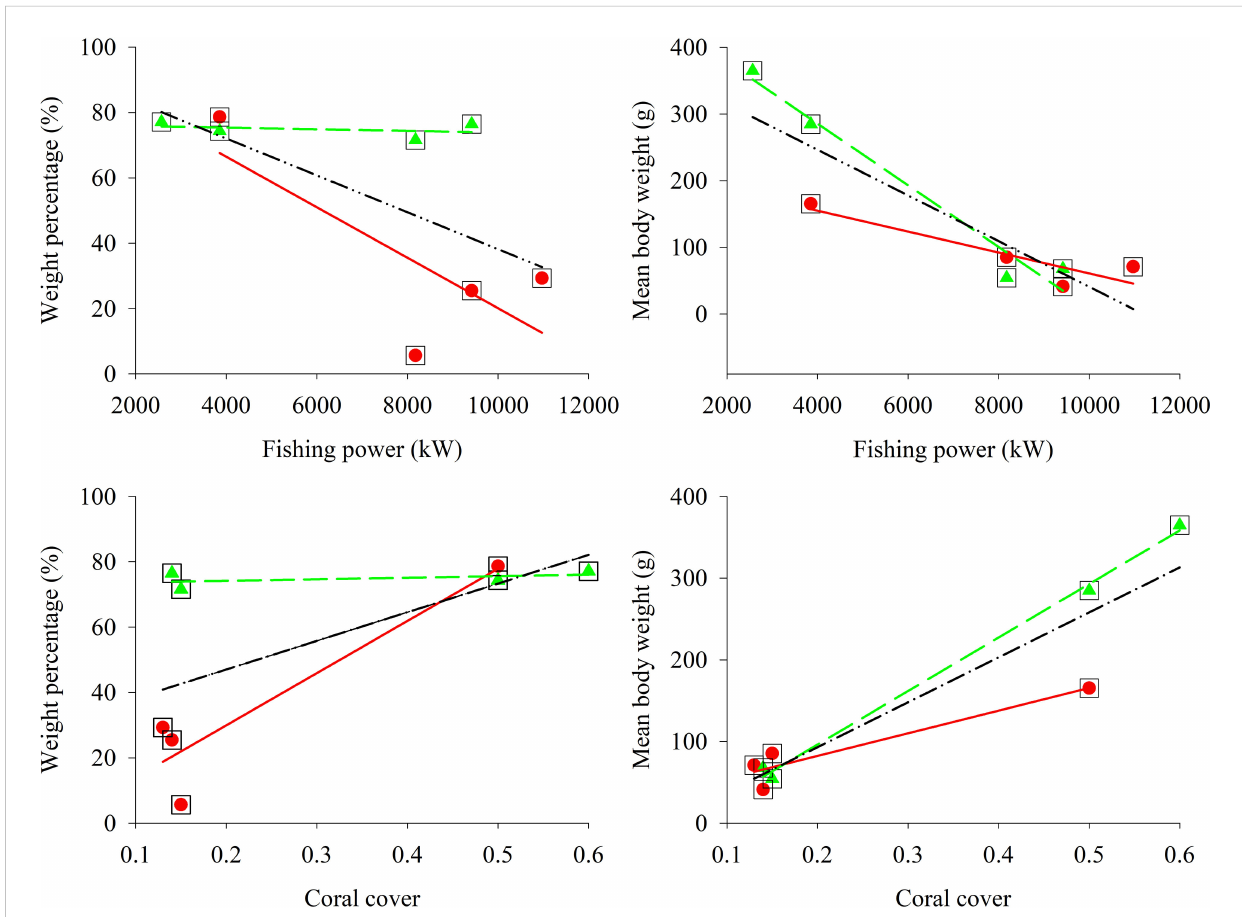
FIGURE 10 Scatter plot and linear fi t between weight percentage and mean body weight of very high & high-value fi sh in the lagoon of in Meiji Reef and fi shing power and coral cover in 1998 — 1999 and 2016 — 2018. and : gillnet, and : hand-line, and : gillnet &